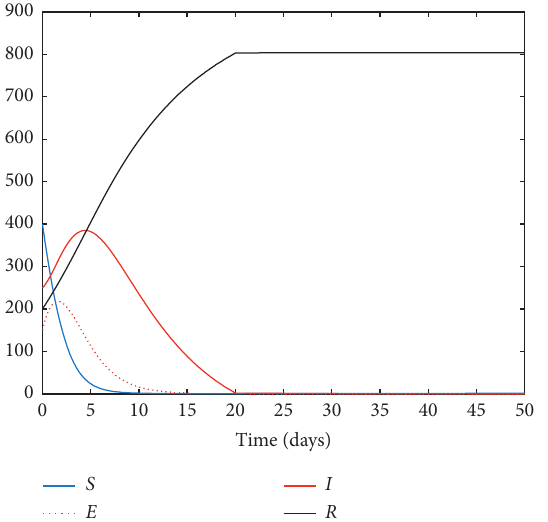
Figure 4: Evolution of the populations with the nonnegative control actions.